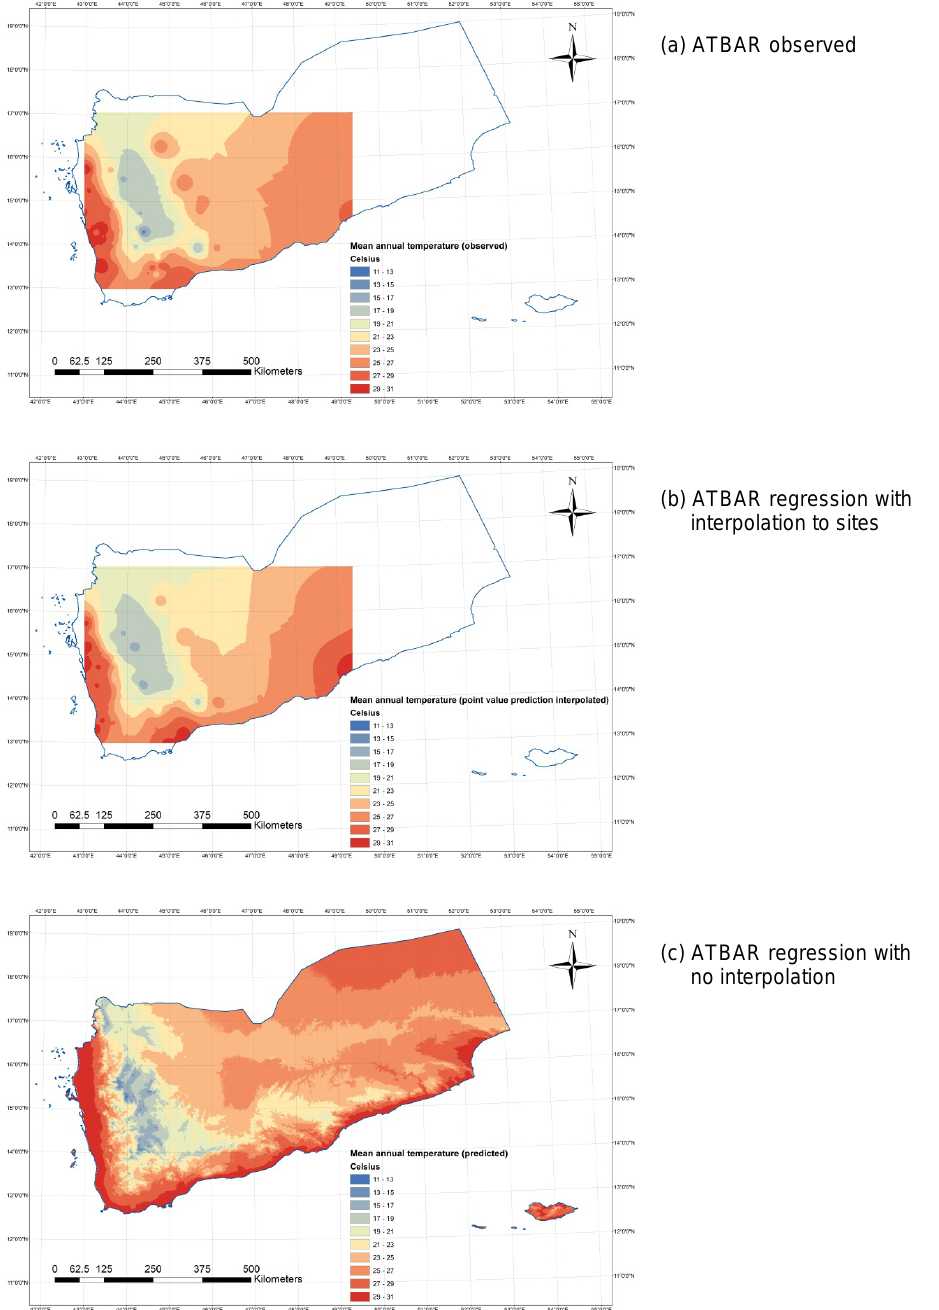
Fig. 16. Observed and modelled annual mean temperature (ATBAR) based on Network